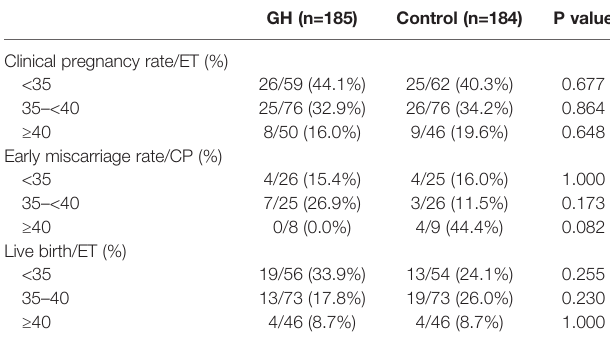
TABLE 5 | Clinical outcomes of frozen-thawed cycles strati fi ed by maternal age.